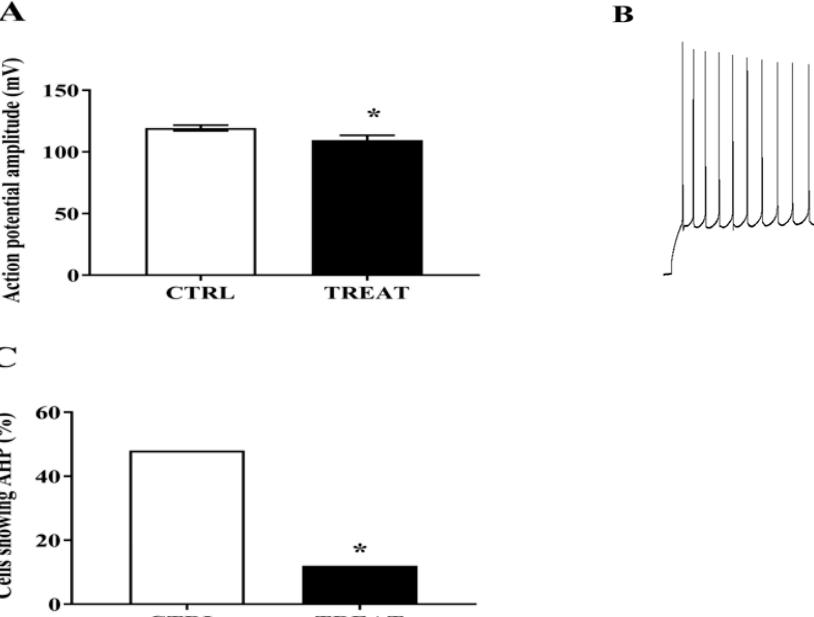
Figure 3. Creatine prenatal treatment effects on CA1 pyramidal cell excitability in adult progeny. ( A ) Neurons of treated rats show lower action potential amplitude than control neurons. Unpaired t -test * p = 0.033; CTRL = 25 neurons; TREAT = 25 neurons. ( B ) Current-clamp recording of action potentials generated by direct intracellular injections of depolarizing current (bringing the membrane potential from approximately − 70 to − 10mV). An afterhyperpolarization is observable following action potential burst. ( C ) Creatine supplementation reduces the afterhyperpolarization appearance in CA1 neurons. CTRL = 25 neurons; TREAT = 25 neurons. Fisher’s exact test: * p = 0.012. CTRL = 5 rats; TREAT = 5 rats.